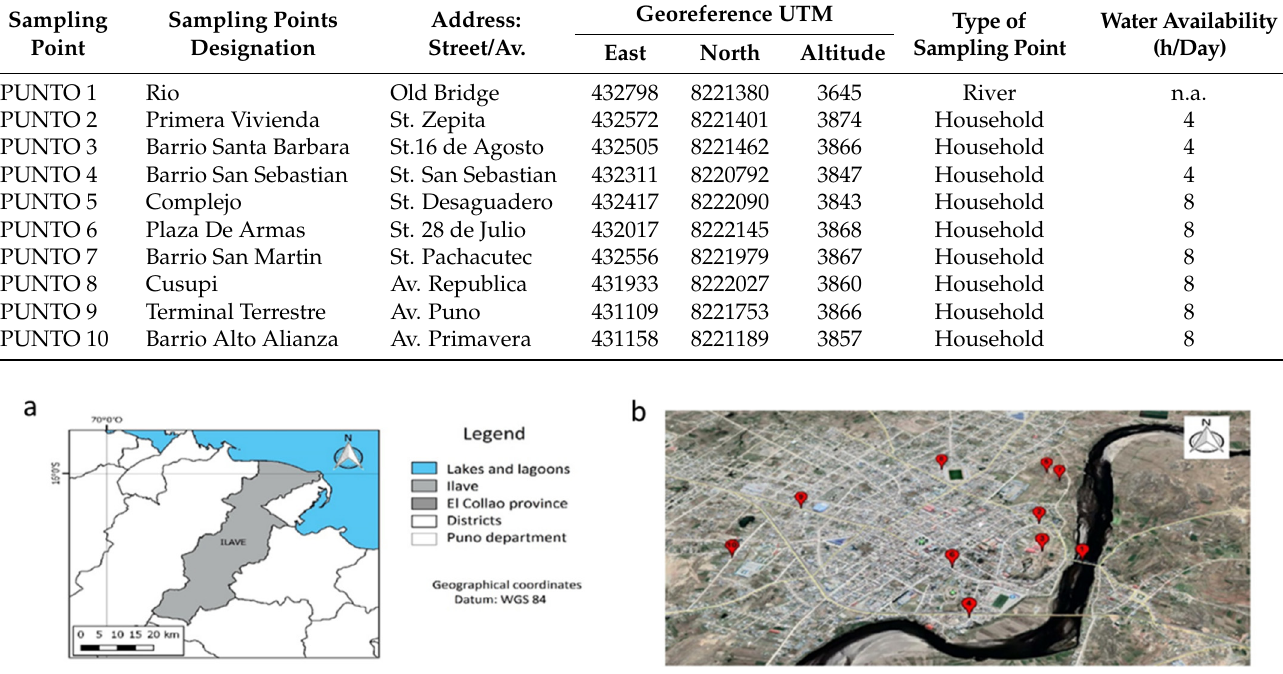
Table 1. Details of the 10 sampling points.